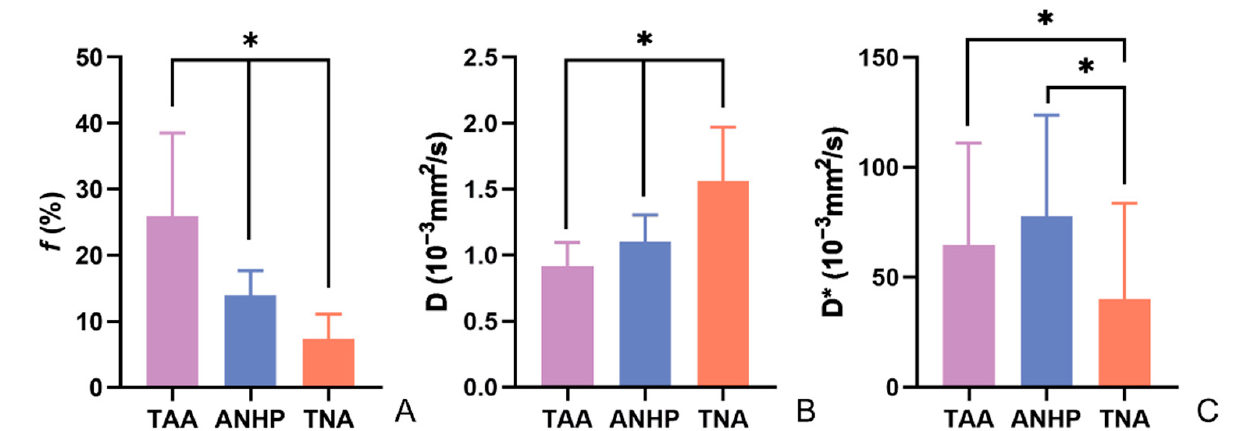
Figure 2. Mean values of various parameters of TAA, ANHP, and TNA. ( A – C ) The mean values of parameters f , D, and D* respectively. TAA: tumor active area; ANHP: adjacent normal hepatic parenchyma; TNA: tumor necrotic area. f : perfusion fraction; D: pure diffusion coefficient; D*: pseudo-diffusion coefficient. * represents that there is an obvious difference ( p < 0.05).